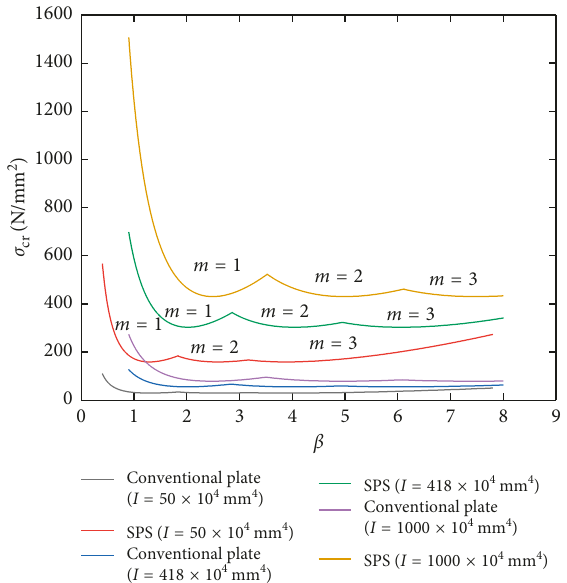
Figure 10: Relation between β and critical buckling stresses (ac- tual) for different inertia moments of the single rib in the SPS and steel